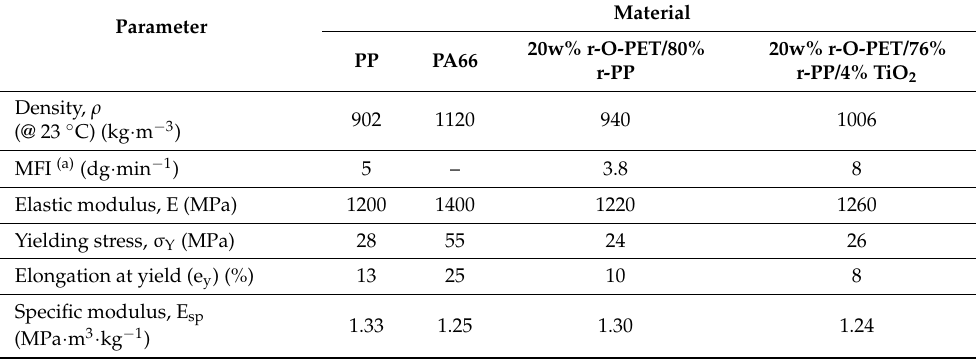
Table 1. Physical, mechanical and flow properties of virgin raw materials and blends selected for the